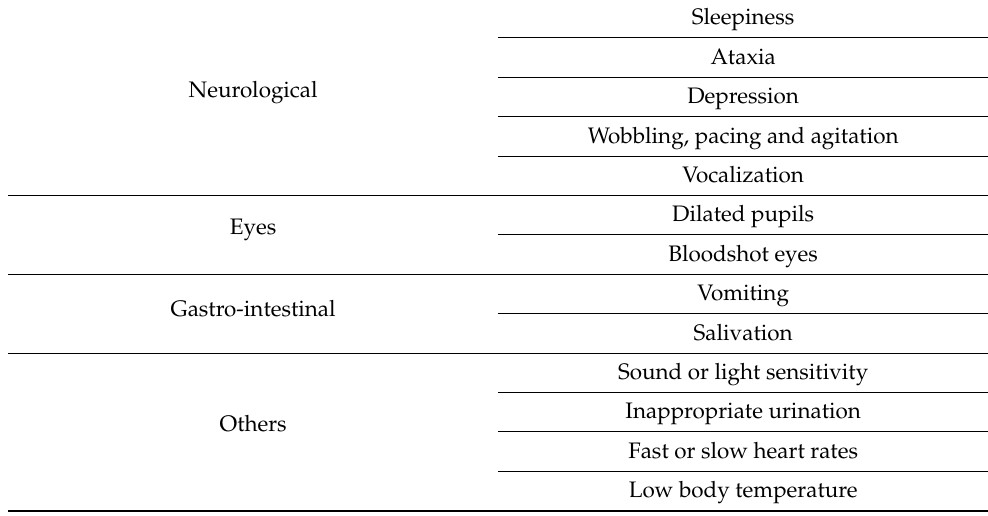
Table 3. The most common signs of excess cannabis exposure in dogs and